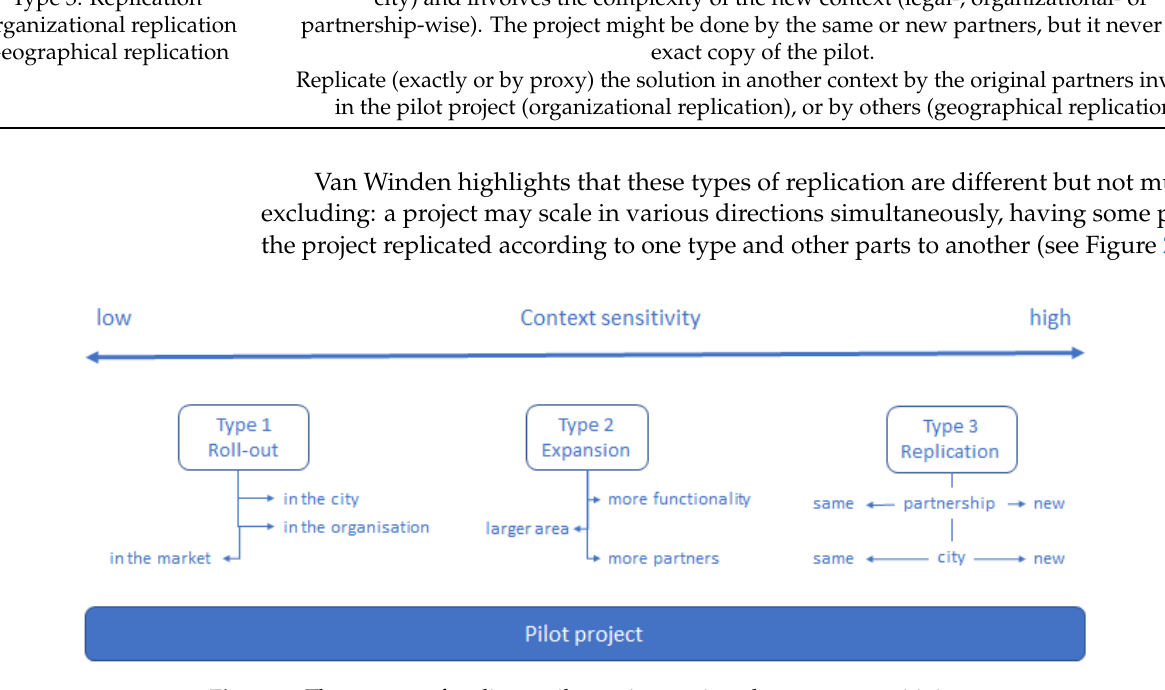
Figure 2. Three types of scaling a pilot project against the context sensitivity.